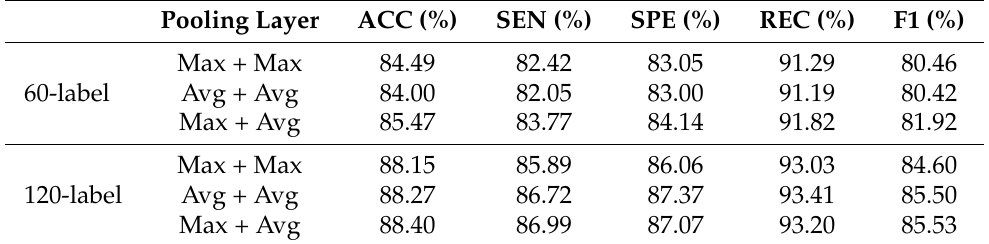
Table 4. Test set evaluation results for DSSL with different encoders in the 60-label case. Pooling